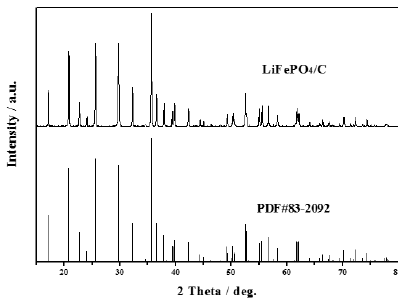
Figure 1. X-ray diffraction (XRD) pattern of LiFePO 4 /C (LFP) sample.